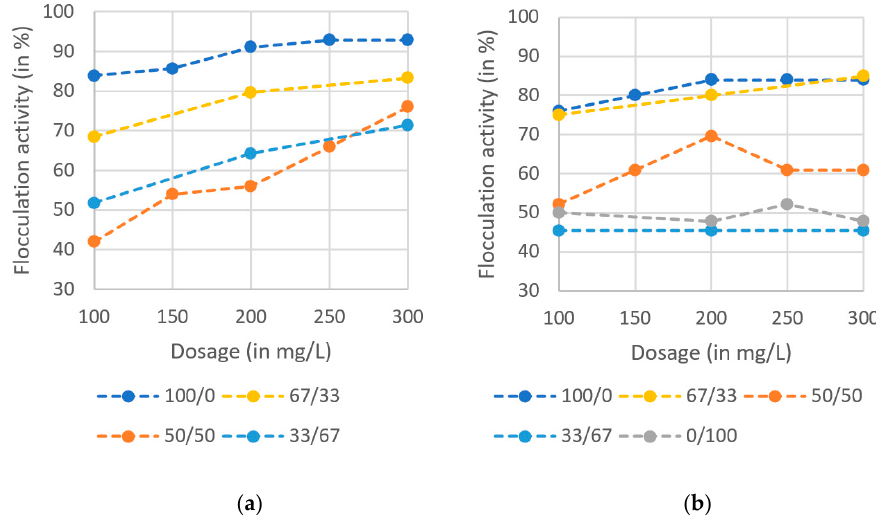
Figure 3. Flocculation activity of flocculants prepared with different mixing ratios of Moringa and cactus in model suspension ( a ) and surface water ( b ).